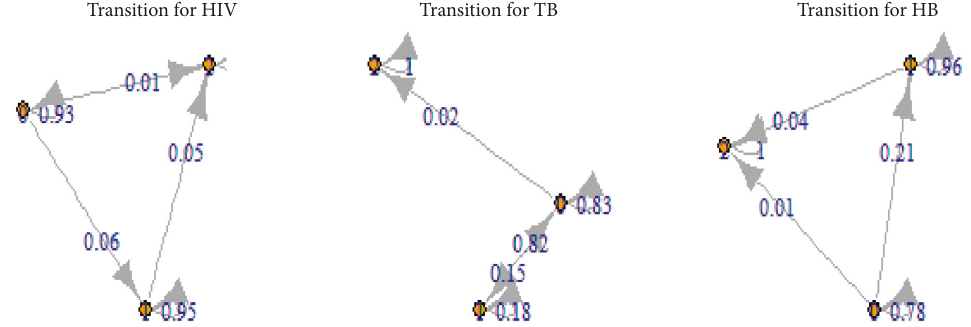
Figure 1: Directed multigraph of transitioning from one state to another.